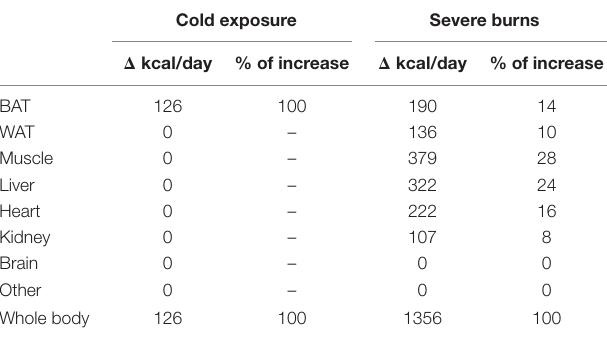
TABLe 2 | The contribution of various tissues to the increase in whole- body metabolic rate accompanying acute non-shivering cold exposure and severe burns.